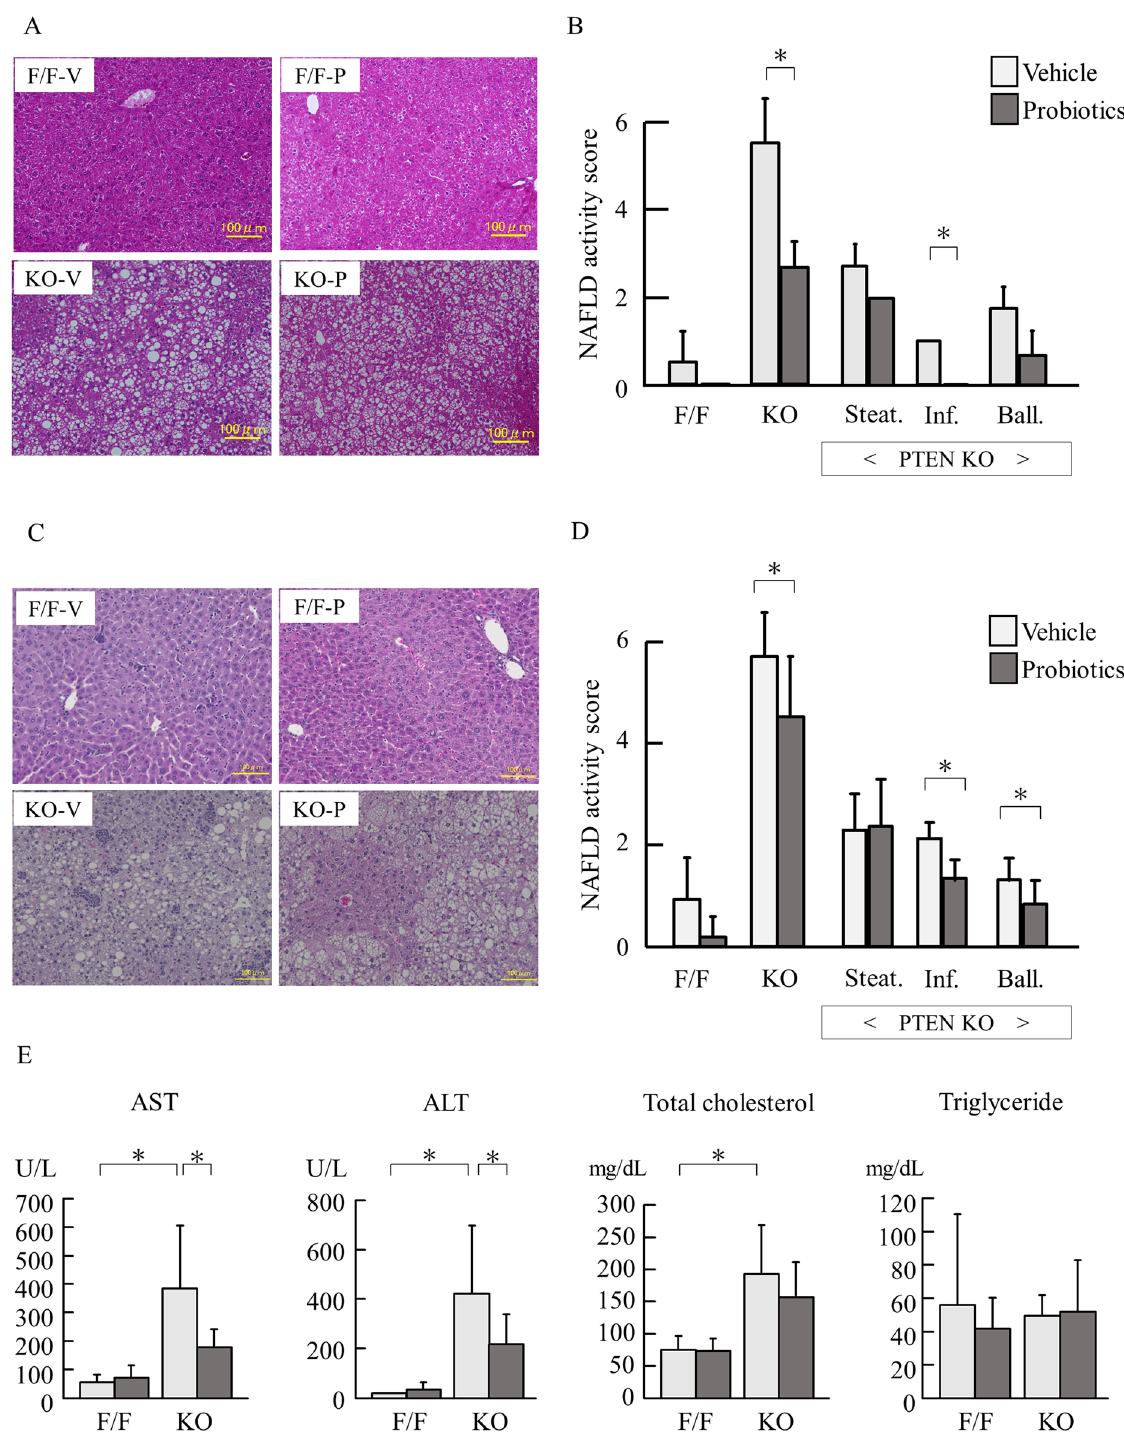
Figure 1. Histological and biological assessment ( A ) The representative of photos of HE staining of the liver in mice treated for 8 weeks probiotics. PTEN KO presented with steatosis, lobular inflammation, and hepatocyte ballooning. ( B ) NAFLD activity score (each group n = 5). In PTEN KO mice, scores of steatosis, inflammation (Inf.), and ballooning (Ball.) are shown. ( C ) The representative of photos of HE staining of the liver in mice treated for 40 weeks probiotics. PTEN KO presented with steatosis, lobular inflammation (Inf.), and hepatocyte ballooning (Ball). ( D ) NAFLD activity score (each group n = 7–16). In PTEN KO mice, scores of steatosis, inflammation, and ballooning are shown. ( E ) Serum levels of transaminases and lipids (each group n = 7–16, Experiments were performed in technically duplicate). Groups were analyzed using the student’s t -test. Data were presented as mean ± standard deviation. F/F, PTEN F/F mice; KO, PTEN KO mice; V, vehicle; P, probiotics; NAS, NAFLD activity score.* P <